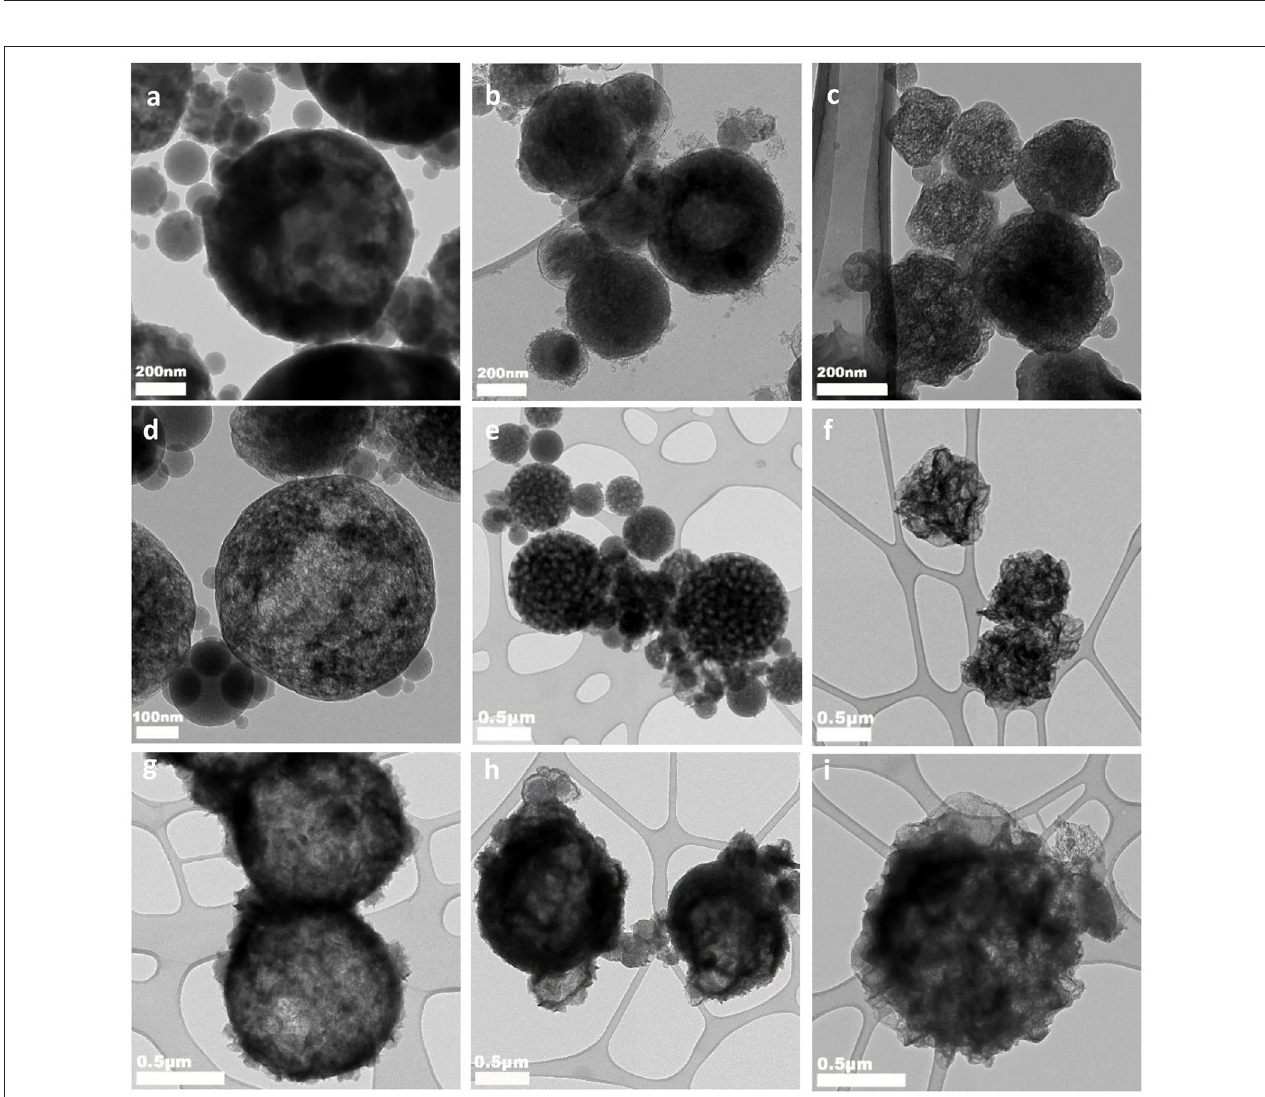
FIGURE 2 | TEM images of (a) Li 2 CO 3 -C NitS , (b) Li 2 CO 3 -C AceS , (c) Li 2 CO 3 -C CarS ; TEM images of the carbon matrix of (d) Li 2 CO 3 -C NitS , (e) Li 2 CO 3 -C AceS , (f) Li 2 CO 3 -C CarS after Li 2 CO 3 removed; and TEM images of (g) Li 2 S-C NitS , (h) Li 2 S-C AceS , (i) Li 2 S-C CarS .